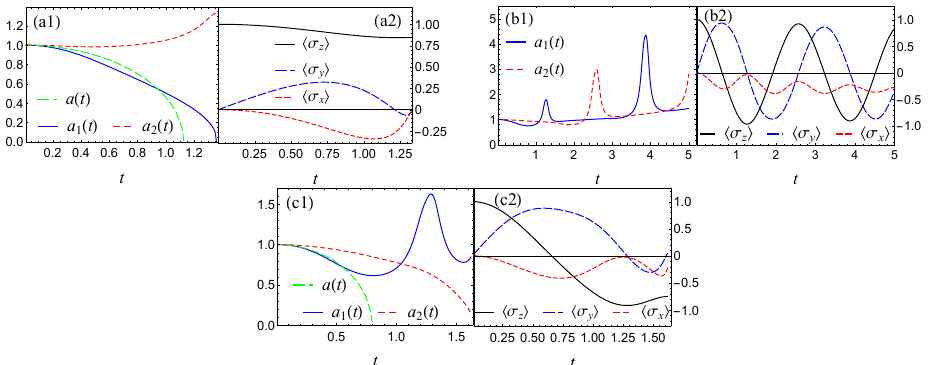
Figure 2. The plot of spin-components width ( a1 – c1 ) and spin rotation dynamics ( a2 – c2 ) versus time for intra-spin interaction κ = − 1 in Equation (1). The panels ( a – c ) correspond to the values of ( gN , Ω ) given as ( 1.32 λ cr ,0.1 λ cr ) , ( 1.32 λ cr ,0.42 λ cr ) , ( 1.57 λ cr ,0.42 λ cr ) from fixed points (1,2,3) in the Figure 1, correspondingly. In the panels ( a1 , c1 ) the width a ( t ) are plotted for Ω = 0 to compare the collapse times with non-spin